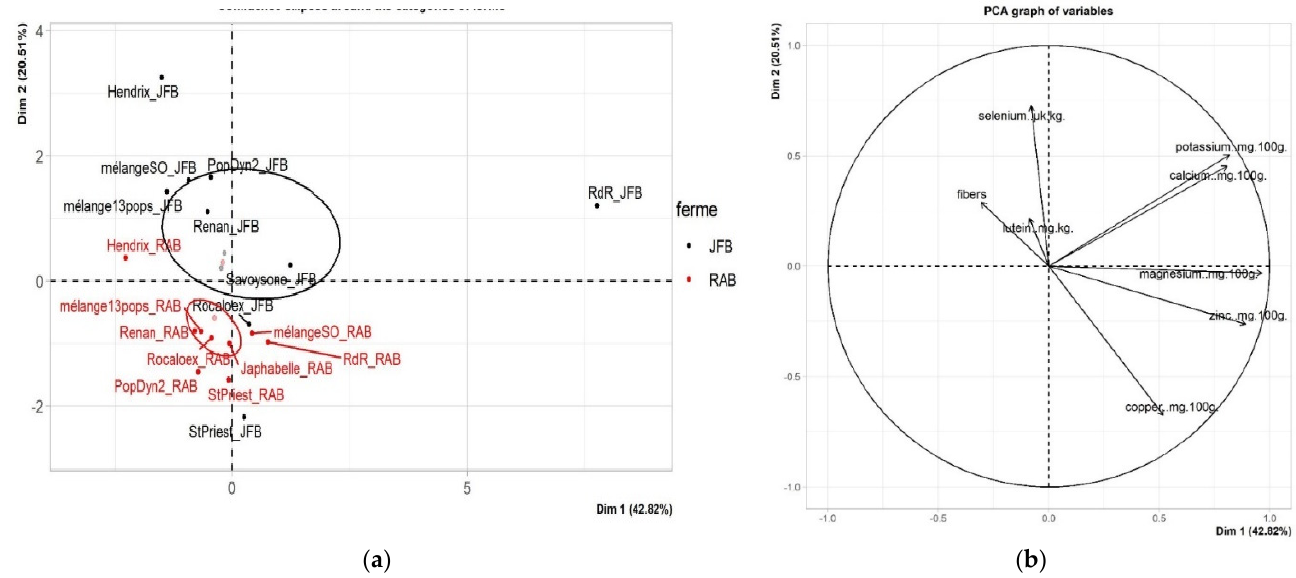
Figure A1. Results of MFA for the 22 varieties*environments samples on nutritional variables, dim 1 and 2: ( a ) graph of the individuals; ( b ) correlation circle.